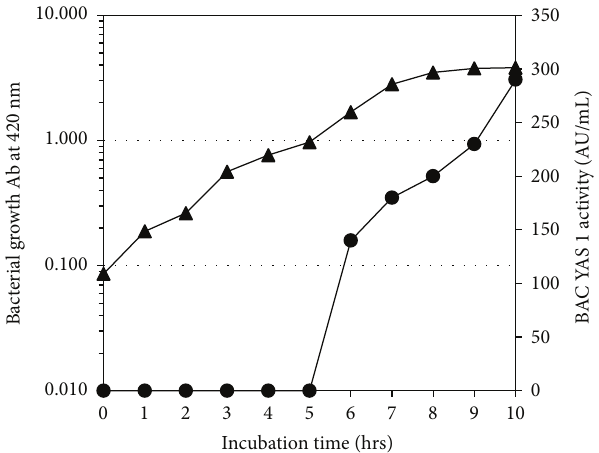
Figure 6: The BAC YAS 1 production time course vs. the growth of Bacillus sp. YAS 1 strain on bacteriocin optimized medium. Symbol 󳵳 : bacterial growth. Symbol e : BAC YAS 1 activity (AU/mL) upon using the indicator strain E. amylovora .